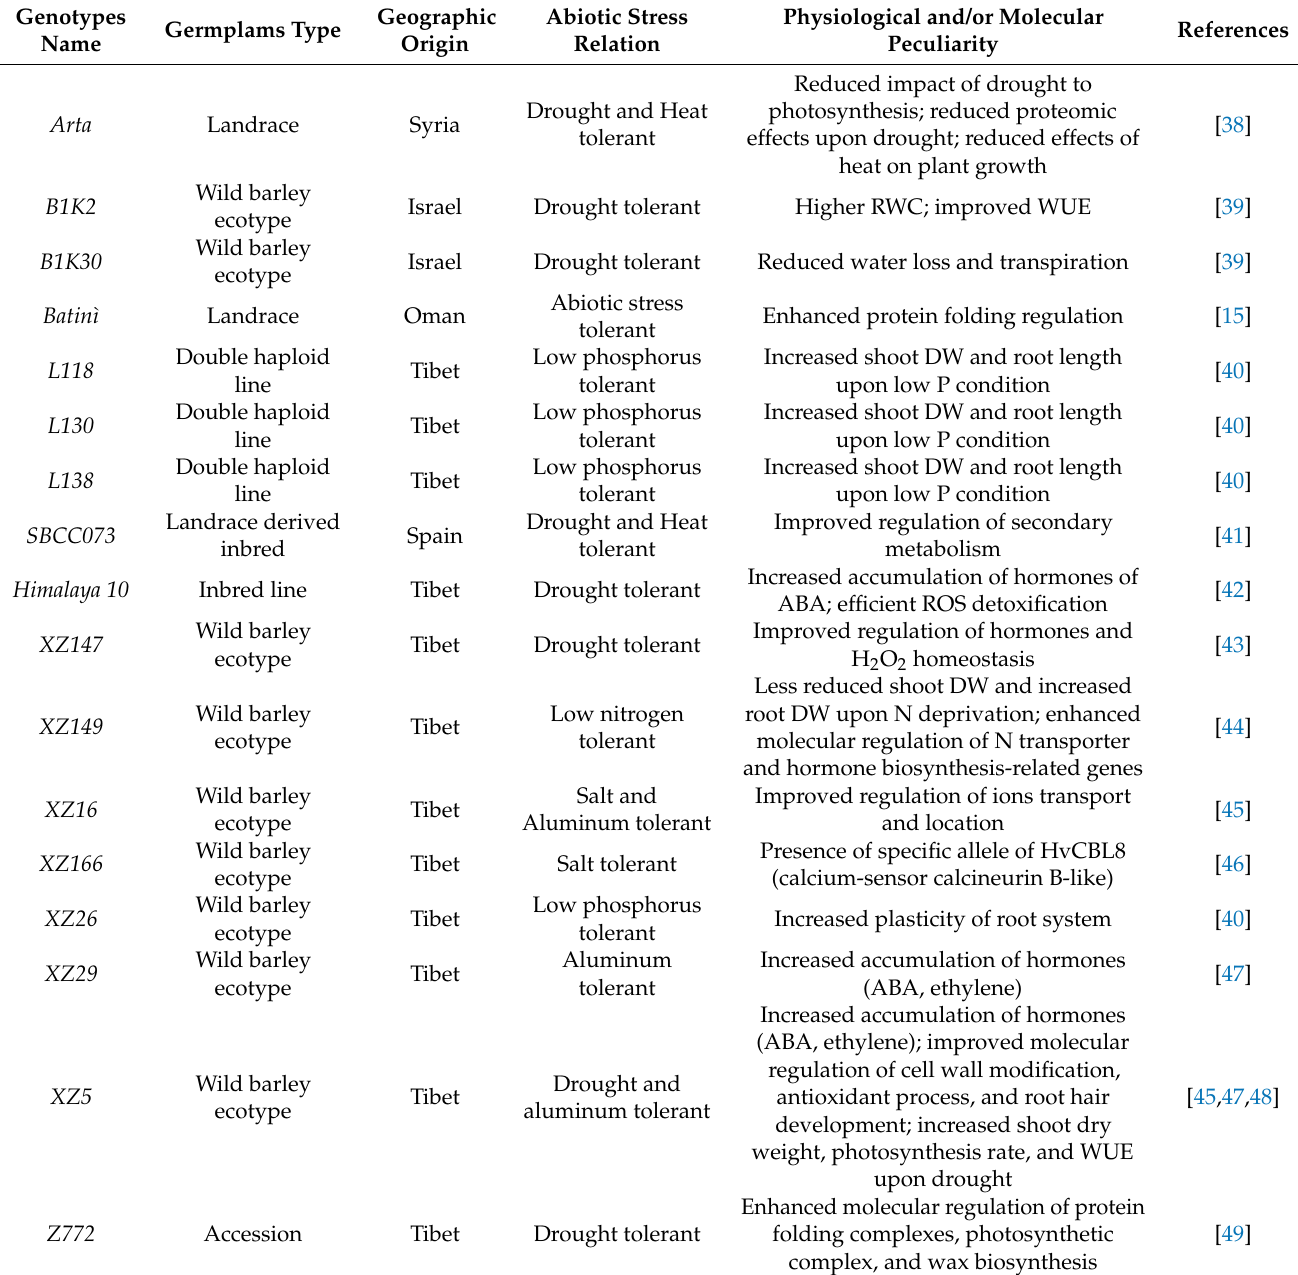
Table 1. List of abiotic stress tolerant genotypes discussed in this